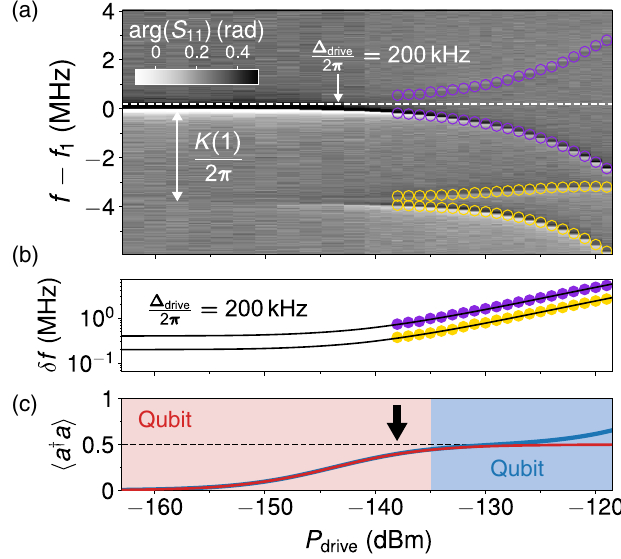
FIG. 11. Two-tone spectroscopy. (a) Phase of the reflection coefficient arg ð S 11 Þ measured with a weak probe tone of constant − 160 dBm in the vicinity of the qubit frequency f power P 1 , in ¼ = 2 π ¼ while an additional microwave drive is applied at Δ drive − f 200 kHz detuning, indicated by the dashed white f 1 ¼ drive line. With increasing drive power P , the fundamental tran- drive sition starts to split into two distinct transitions, because of the Autler-Townes effect [71], observed at frequencies f ¼ (cid:2) f 1 (cid:2) Ω = 2 π [35,71]. Since the population of the first excited R ≥ − 150 dBm a second state increases with drive power, at P drive transition becomes visible at 3.9 MHz below f 1 . This corresponds to the j 1 i → j 2 i transition. The measured anharmonicity α ¼ 2 π × 3 . 9 MHz, as well as the qubit frequency f 7 . 6790 GHz, 1 ¼ are slightly different than the values reported in the main text, due to the fact that the measurements were taken in different cooldowns. In total we performed seven cooldowns, summarized in Table II. Similar to the fundamental transition, the second transition also splits with increasing P [71]. (b) Extracted drive frequency splittings δ f for the first two transitions. The black lines correspond to the theoretical predictions 2 Ω (first tran- R sition, purple markers) and Ω (second transition, R